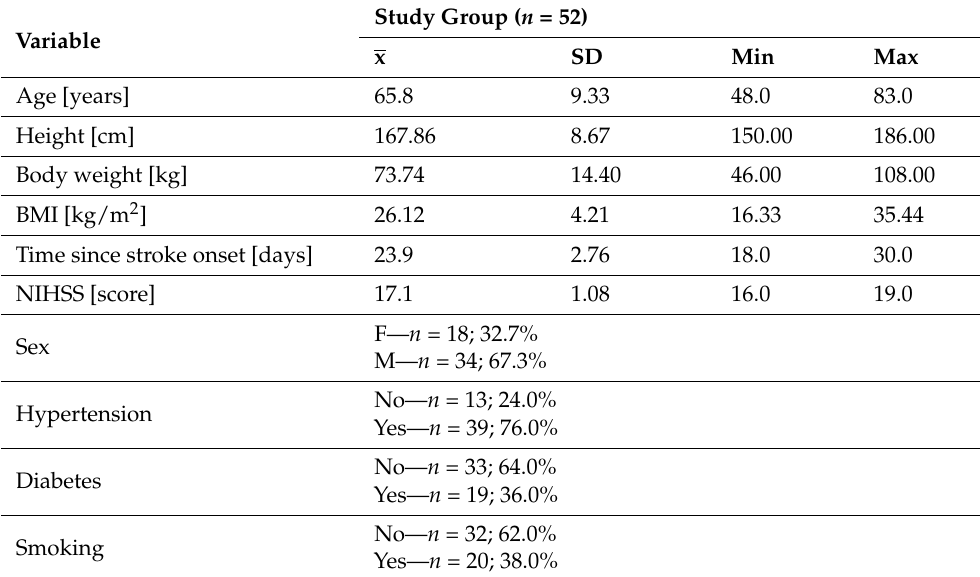
Table 1. Characteristics of the study